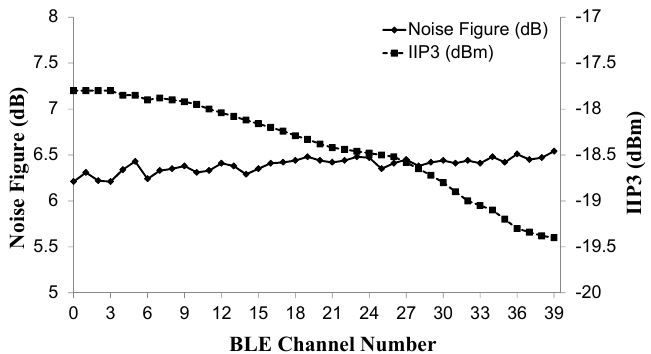
Figure 24. IIP3 and NF measurement results with respect to BLE channels.